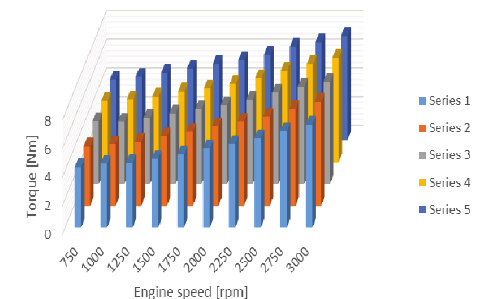
Fig. 5. Course of torque for the five series measuring – oil temperature